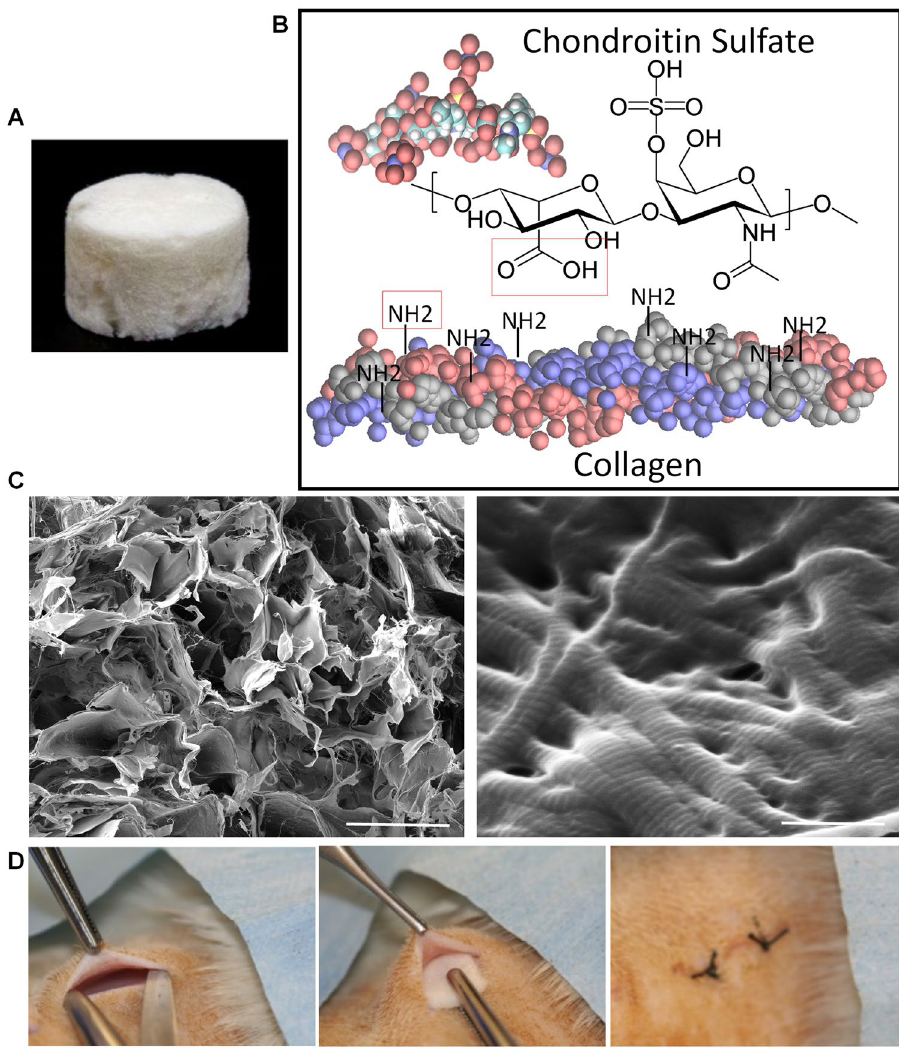
Figure 1. ( A ) Photograph of the collagen (CL)-chondroitin sulfate modified scaffold (CSCL). ( B ) Carbodiimide chemistry schematic to covalent link the chondroitin sulfate to Collagen structure. The carboxylic acid presented on CS sequence forms an amide bond with the free primary amines present on the collagen sequence. ( C ) SEM images showing scaffold’s porosity (on the left site) and the intact nanostructure of the collagen fibers (on the right site). (Scale bars: 100 μ m and 500 nm). ( D ) Pictures showing the subcutaneous implant